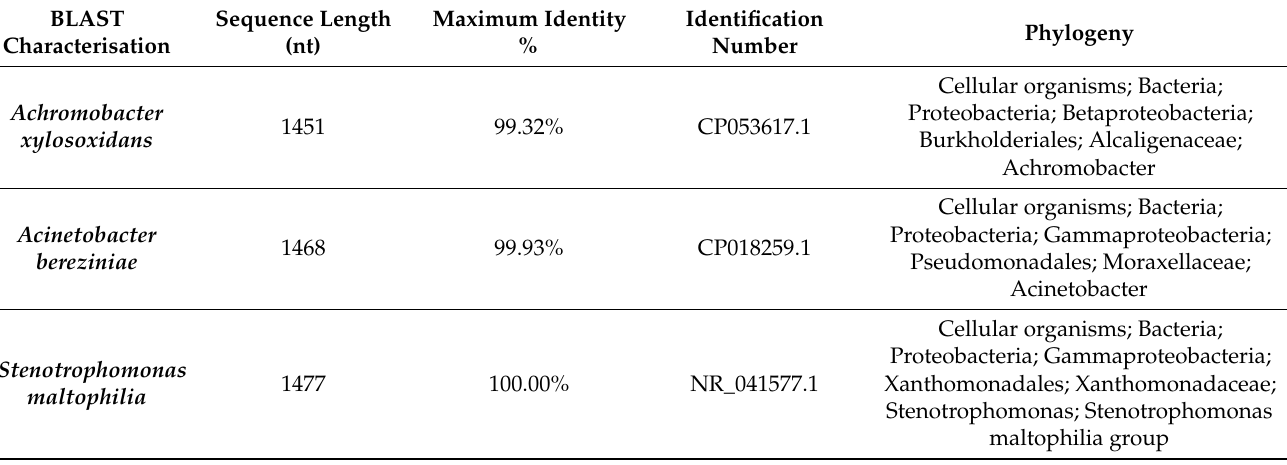
Table 1. BLAST characterisation of rRNA sequence of isolated bacteria at the MFC’s anode with papaya juice substrate.